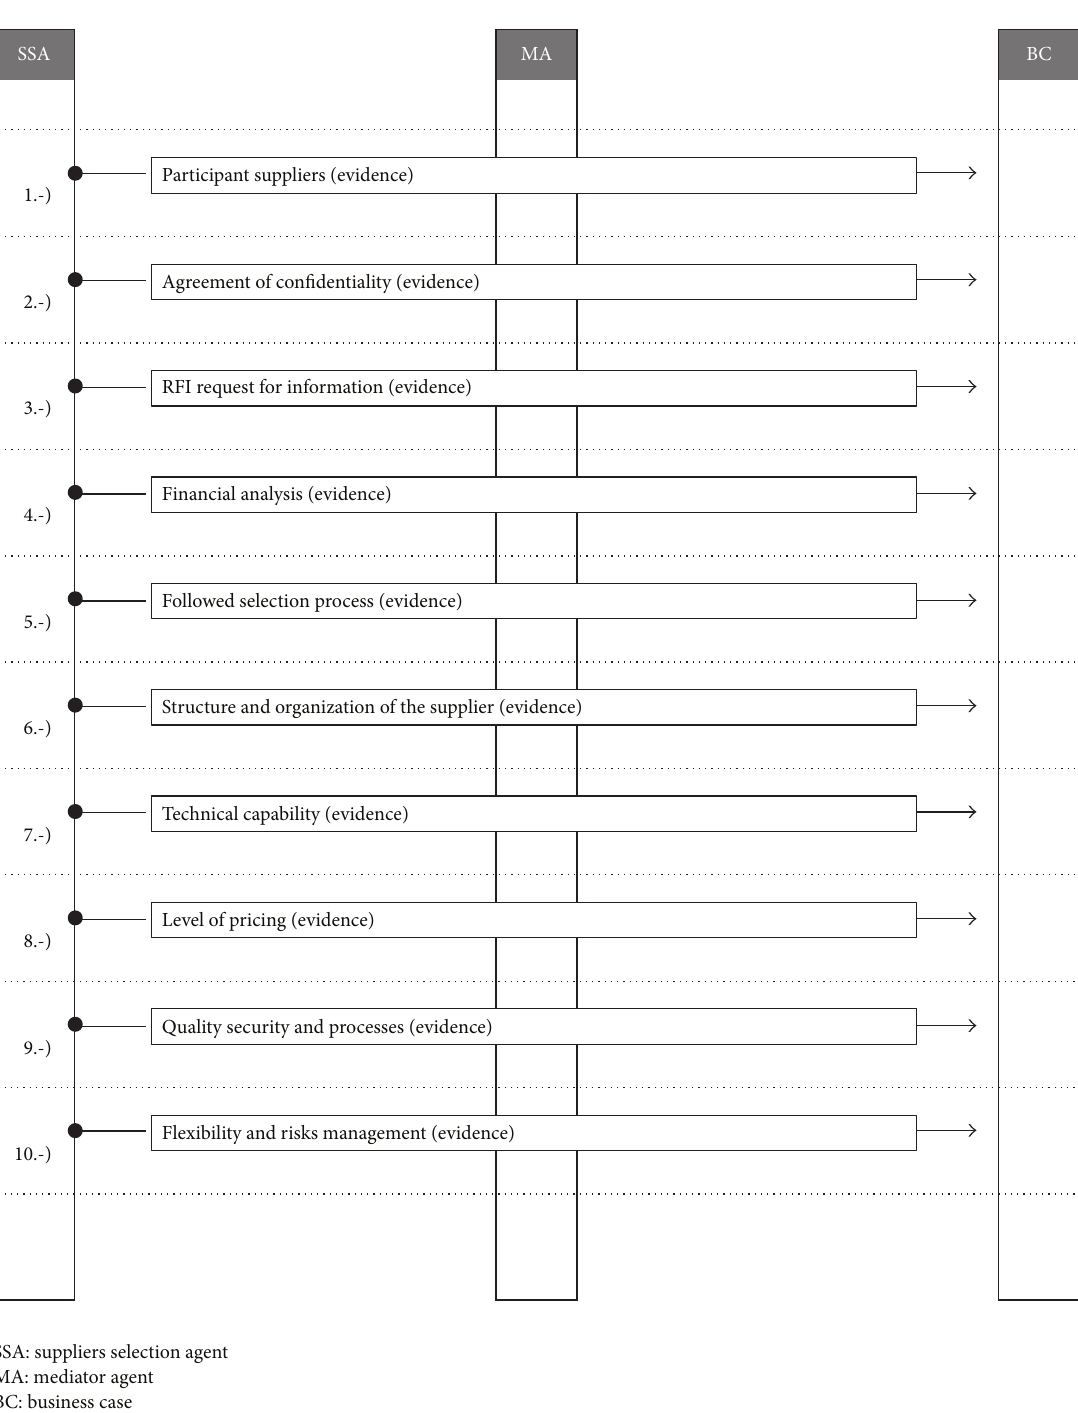
Figure 1: Facts Searching Discussion